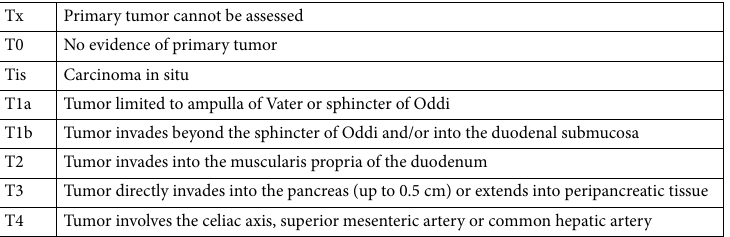
Table 1. Definitions of ampullary tumor invasion by the American Joint Committee on Cancer, 8th edition.